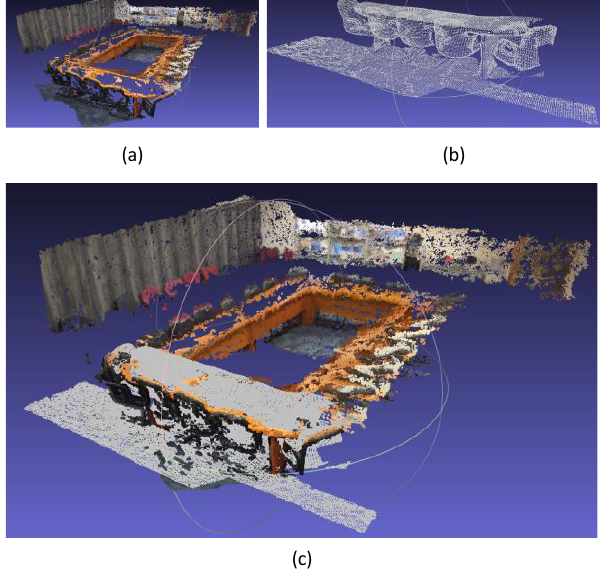
Table 2. Statistics of discrepancies in object space